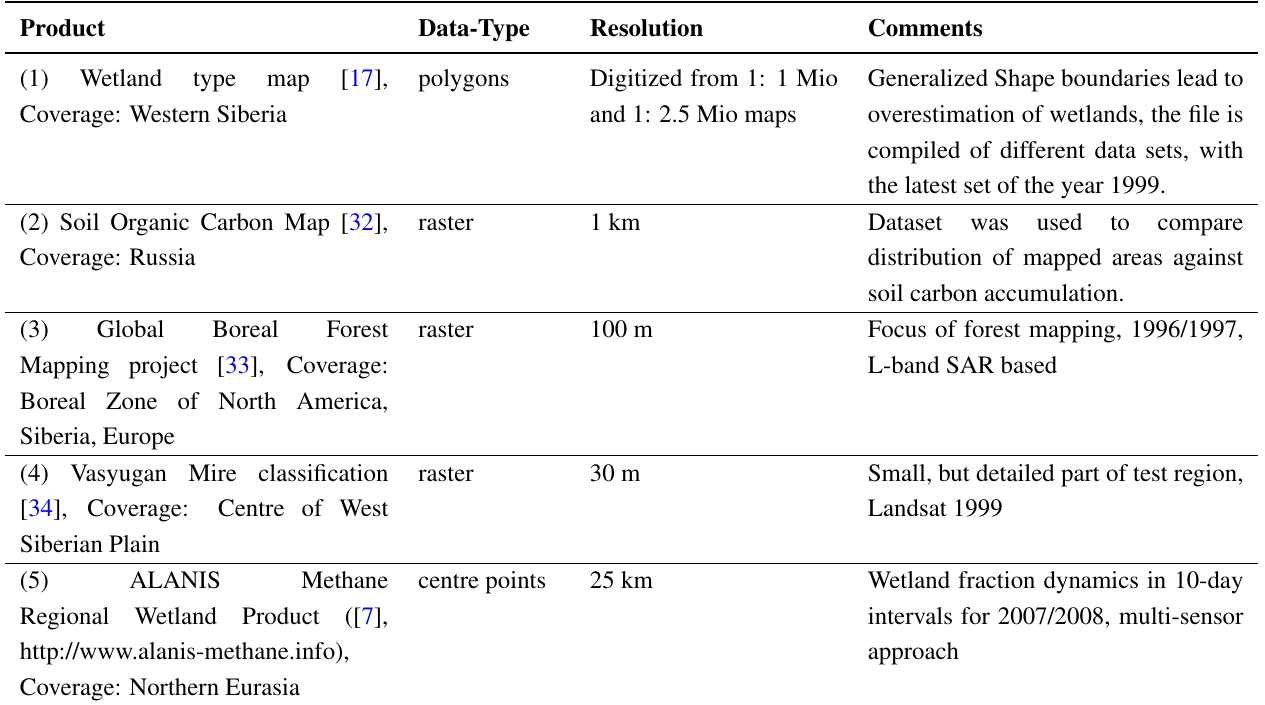
Table 1. Products used for validation